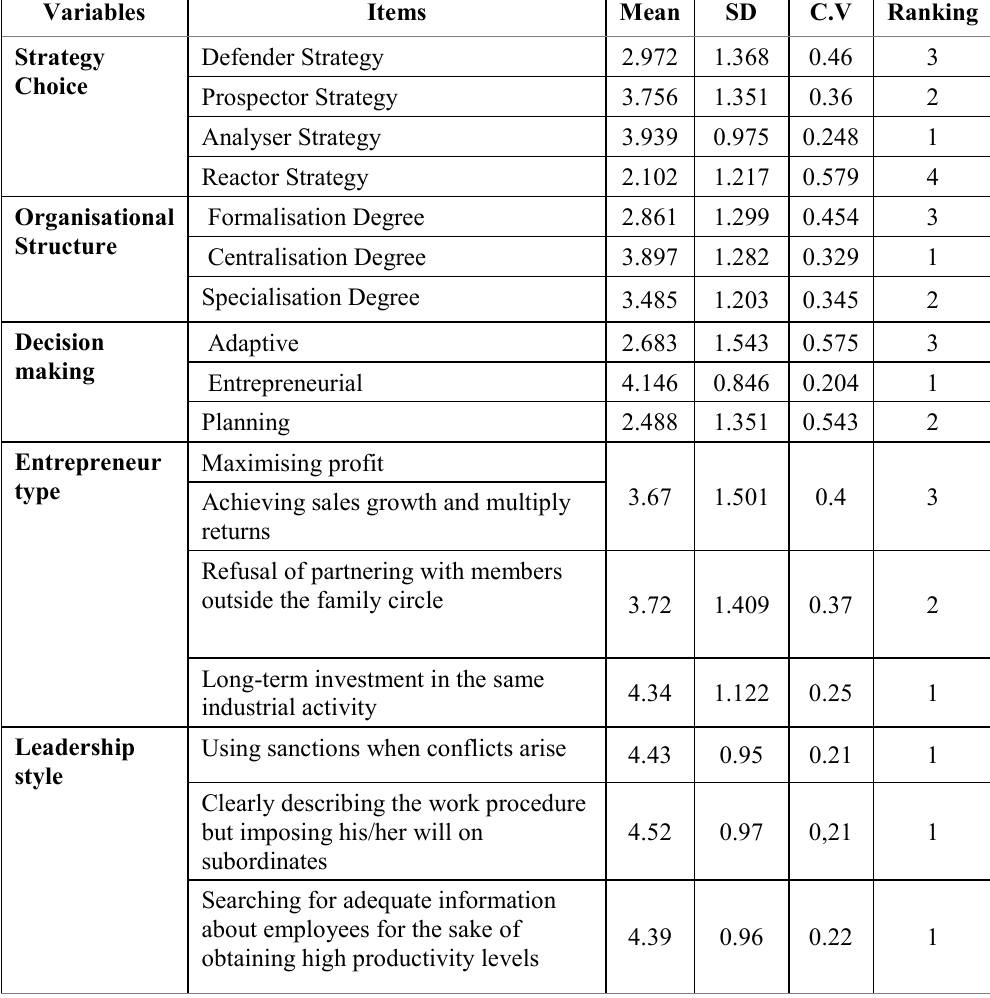
Table 1. Coefficient of Variance of Research